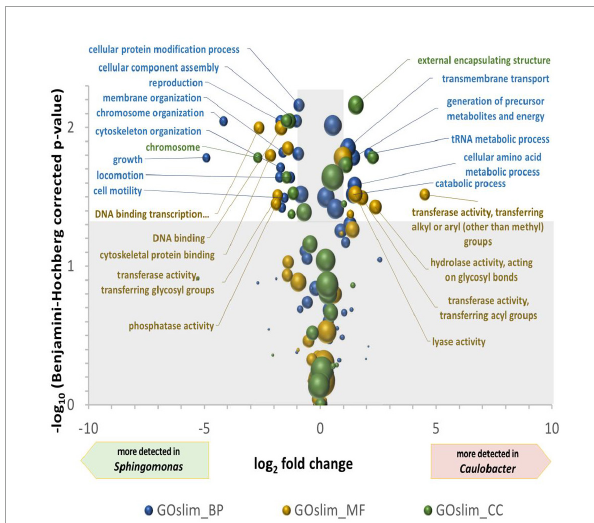
FIGURE4 Volcano plot of the differential detection of GOslim terms between Caulobacter and Sphingomonas . The X-axis is the ln2 of the quantification of GOslim terms associated to Caulobacter divided by their quantification associated to Sphingomonas. The Y-axis is the -log10 of bilateral T-test p -values, after Benjamini–Hochberg multiple tests correction, comparing the four quantifications of Caulobacter and Sphingomonas GOslim terms in the four wall scrubs. The areas of the spheres are proportional to the defined quantification of the Caulobacter and Sphingomonas GOslim terms. Significantly different GO terms between genera are found in the unshaded area, i.e., with more than two-fold modulation and a –log ( p -value) greater than